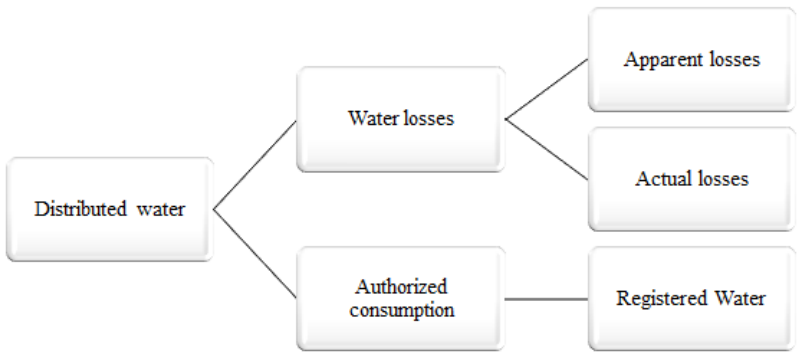
Figure 1. Schematic diagram of water losses in distributed water.